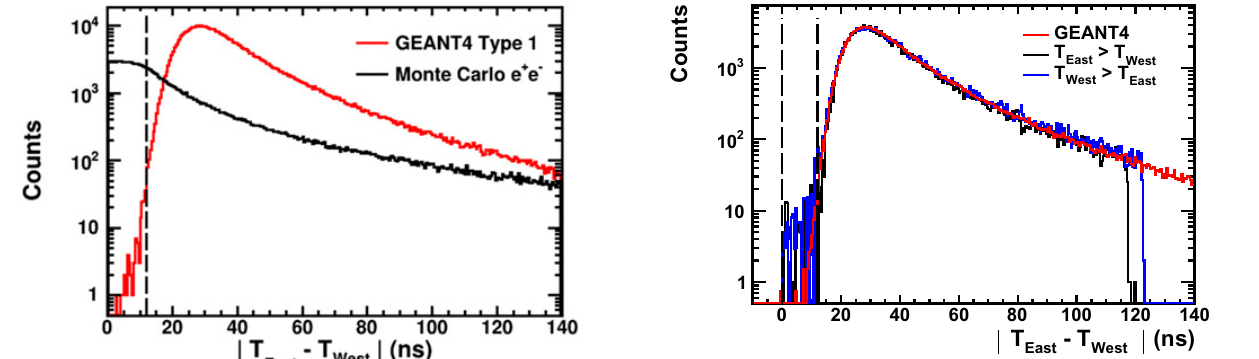
Figure 7. Shows the background-subtracted, relative time differences between events that first trigger the East detector (blue) and events that first trigger the West detector (black). An overlaid GEANT4 simulation (red) shows the expected timing spectrum for conventional β -decay Type 1 backscatter events. Dotted lines illustrate the chosen time window used in this analysis to identify candidate dark matter decays. Bin width of 50